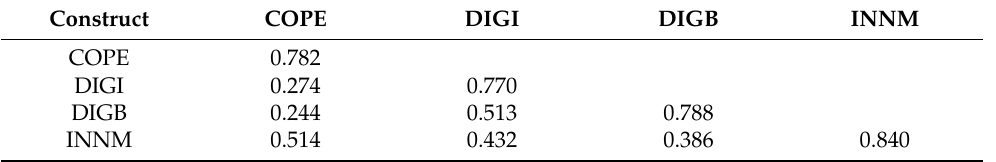
Table 4. Discriminant validity of the model: Fornell and Larcker criterion.